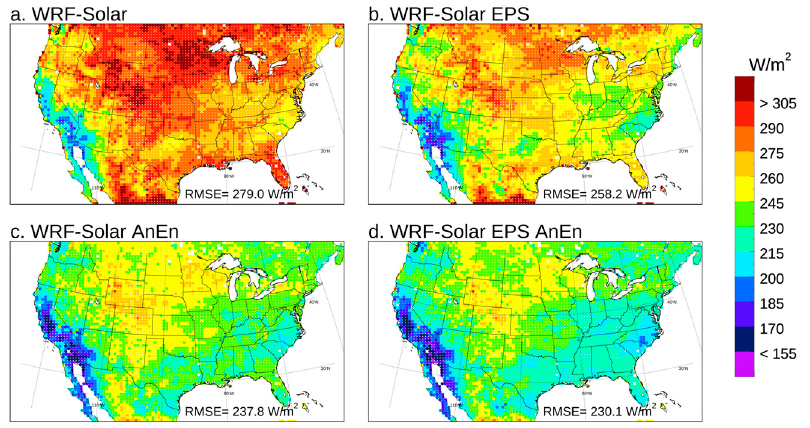
Figure A1. Root mean squared error (RMSE) computed for DNI over the year 2018 for the forecast lead times from +24 to +48 h. The value in the legend at the bottom of each panel indicates the RMSE computed by pooling all the grid points and lead times together.